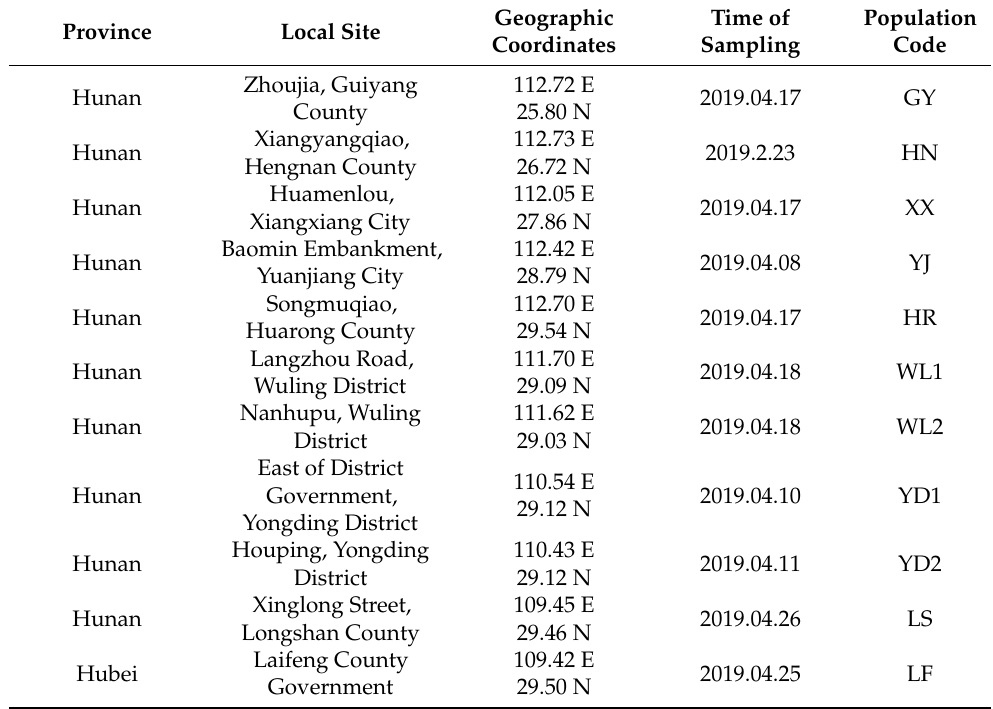
Table 1. Geographic information for the 11 sampling sites, sampling time, and abbreviated code for each. The sample sizes of F. commune strains obtained at the 11 sites are shown below and analyzed in the Results